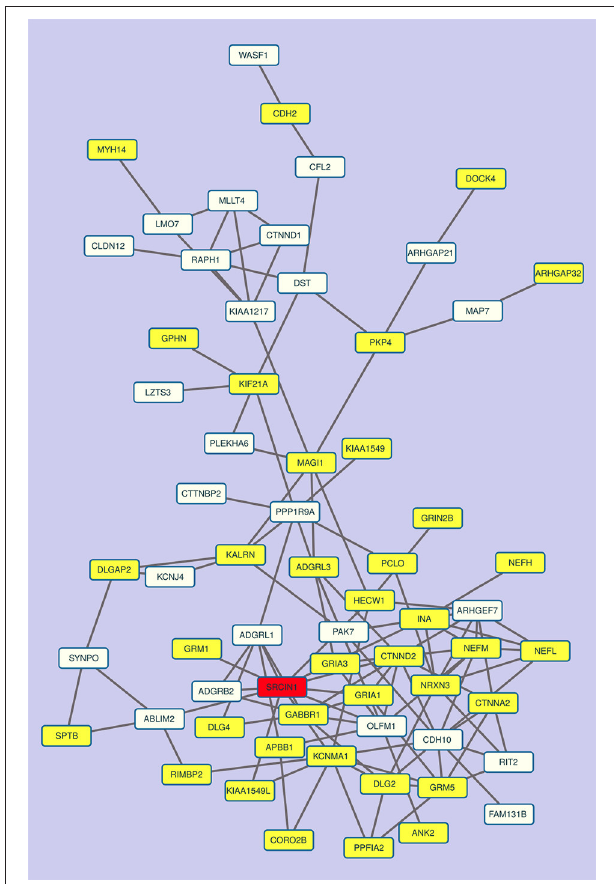
FIGURE 5 | The co-expression sub-network of p140Cap and its interactors contains relevant disease genes. The most connected component of the co-expression network in “All Tissues CCN.” p140Cap is shown in red, disease genes are in